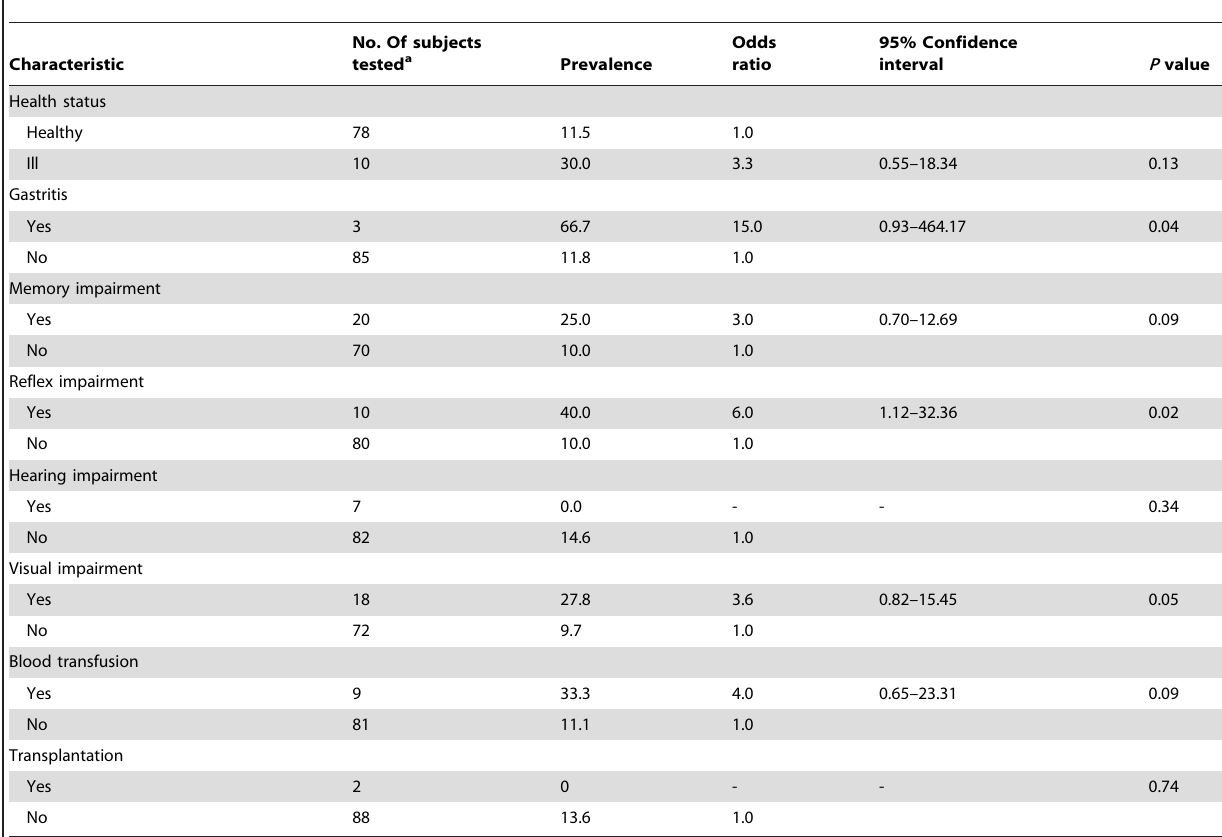
Table 2. Seroprevalence (%) of toxocaral infection in waste pickers relative to bivariate analysis of clinical characteristics.